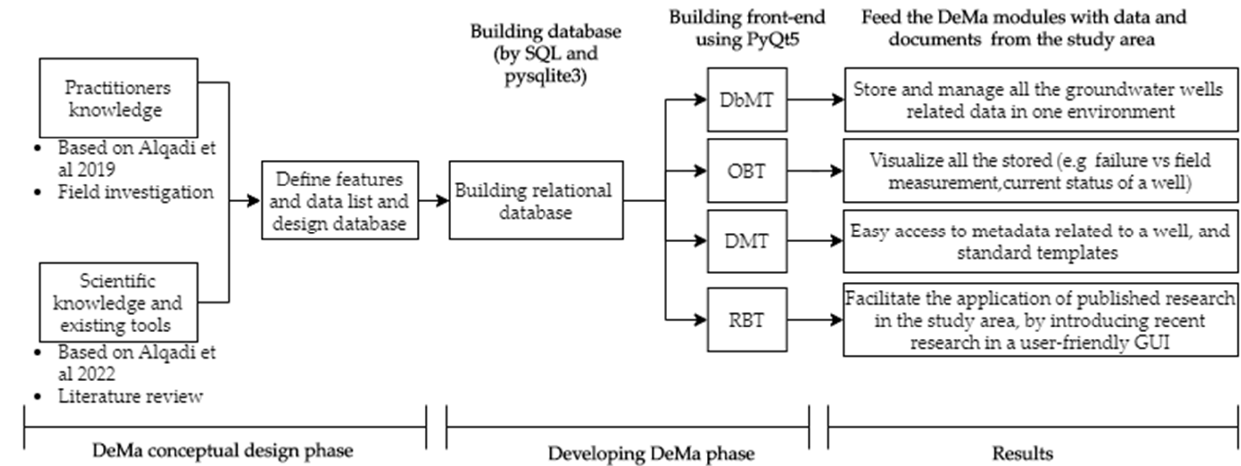
Figure 3. Schematic diagram for the method followed to apply DeMa on the Wadi Al Arab wellfield. Acronym list: database management tool (DbMT), observation-based tool (OBT), documents-based tool (DMT), research-based tool (RBT) [33,91].